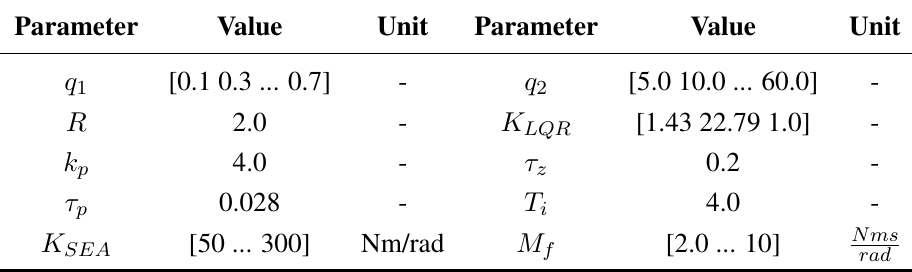
Table A2. Controller weightings and parameters for the classical